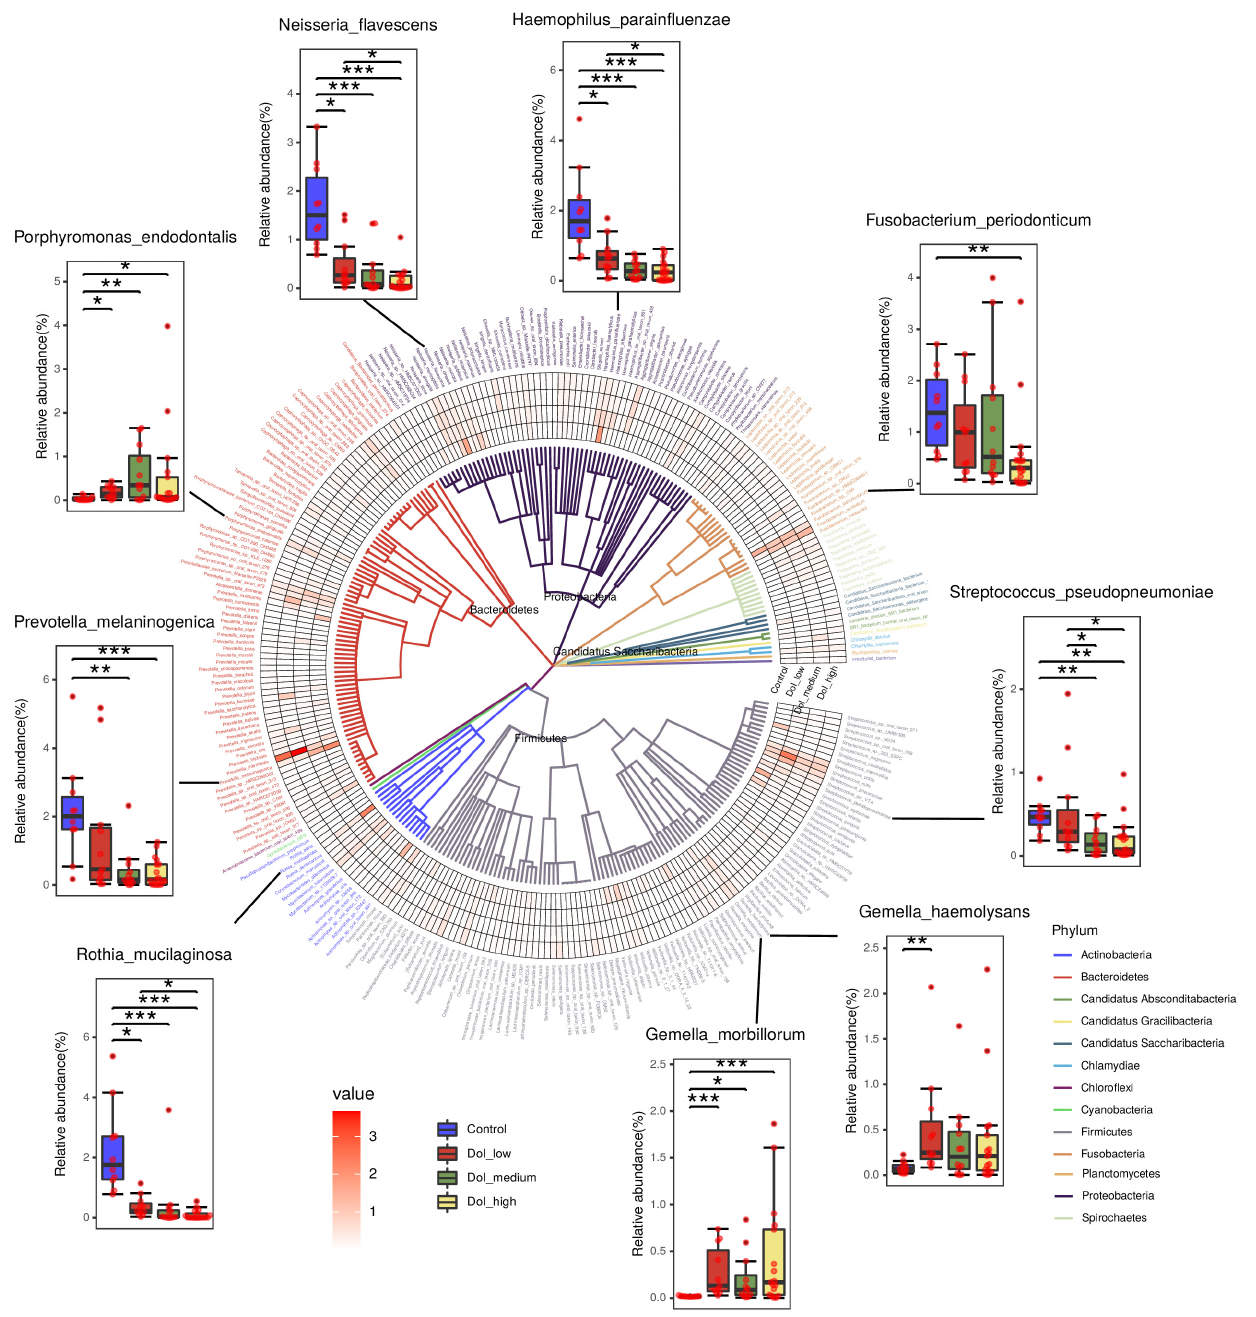
FIGURE 3 | In total, 290 differentially abundant species are shown in a phylogenetic tree, grouped in the phyla Proteobacteria , Bacteroidetes , Fusobacteria , Firmicutes and Actinobacteria . In the outer circles, species are marked for relative abundance. The darker the color is, the higher the abundance. Columns were used to display the abundance changes in nine species between groups. (Dunn’s test to compare differences between groups, * p < 0.05, ** p < 0.01, *** p <